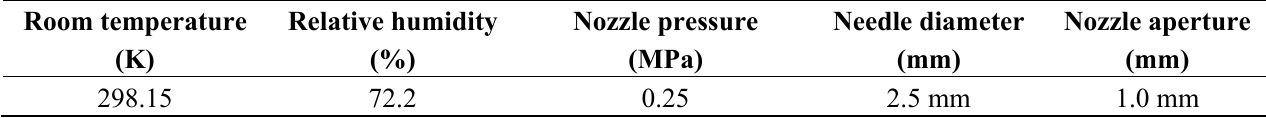
Table 2. Experimental conditions for characterizing the electrostatic atomization of biodiesel. Room temperature